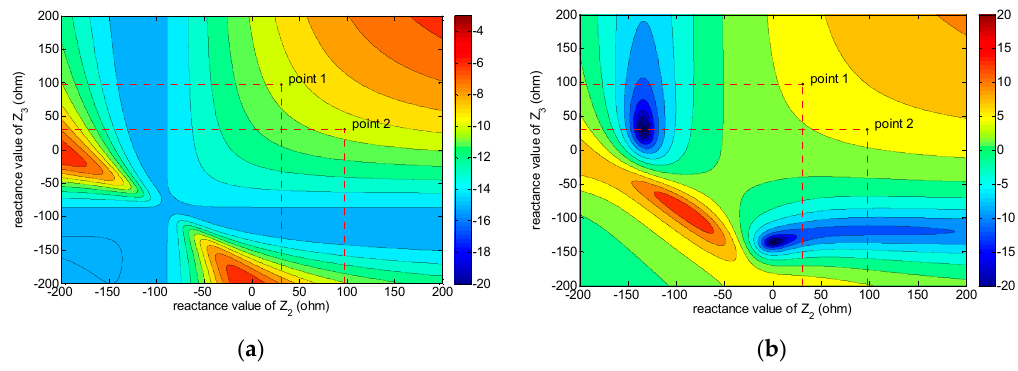
Figure 4. The return loss and gain distribution versus Z 2 and Z 3 . ( a ) Return loss. ( b ) Gain at φ = 90°, θ = − 20° (The horizontal axis and the vertical axis are the reactance value of load Z 2 and load Z 3 ). The value of load Z 2 and Z 3 can be reconfigured among Point 1 and Point 2 shown in Figure 4 by changing the operating modes. Each RF MEMS switch has two states, i.e., an up state (0) and a down state (1). The input impedance of the Part 2/Part 3 is (0.0808 + j 1.1140) × 87.5 Ω ≈ (7 + j 98) Ω in the “0” state, and (0.05 + j 0.3503) × 87.5 Ω ≈ (4 + j 31) Ω in the “1” state according to the simulated results, the